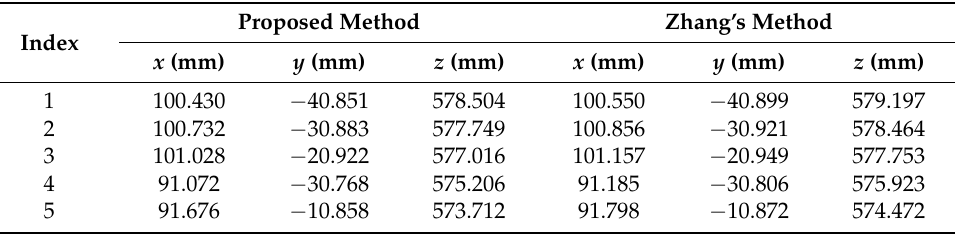
Table 3. Comparison of the 3D reconstruction